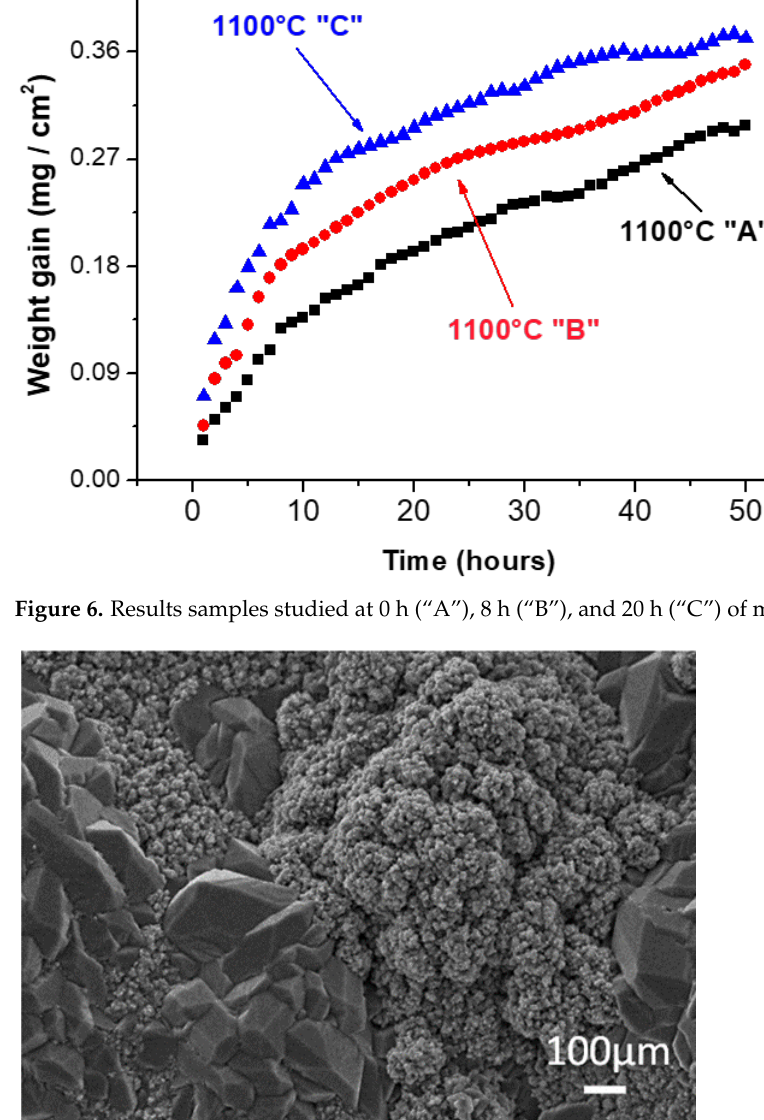
Figure 7. SEM image shows Nb